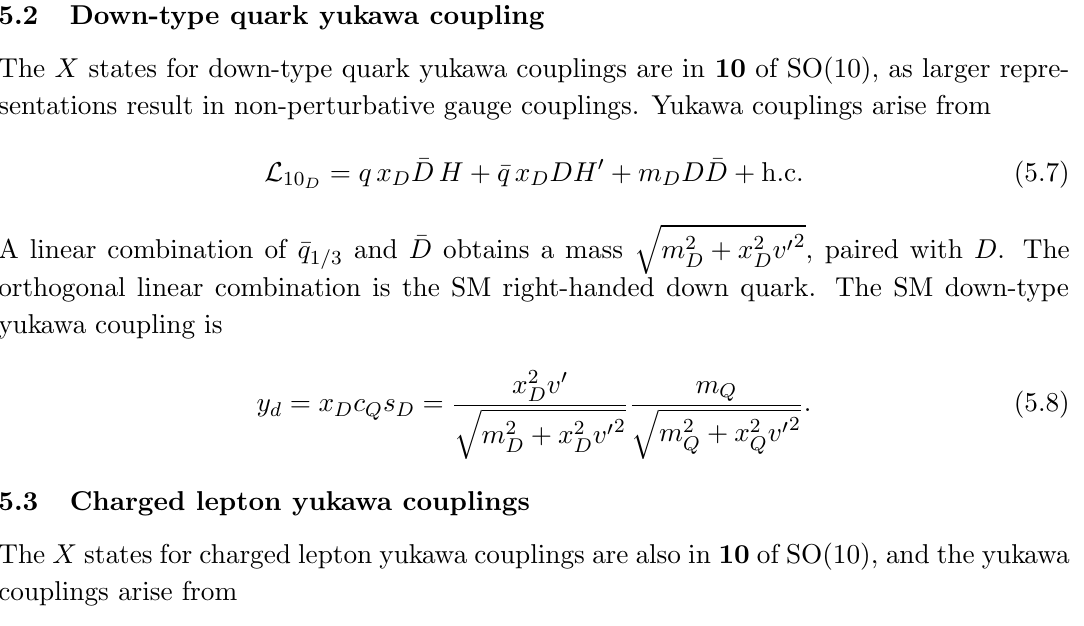
x X v 0 , s X = x X v 0 = (cid:29)